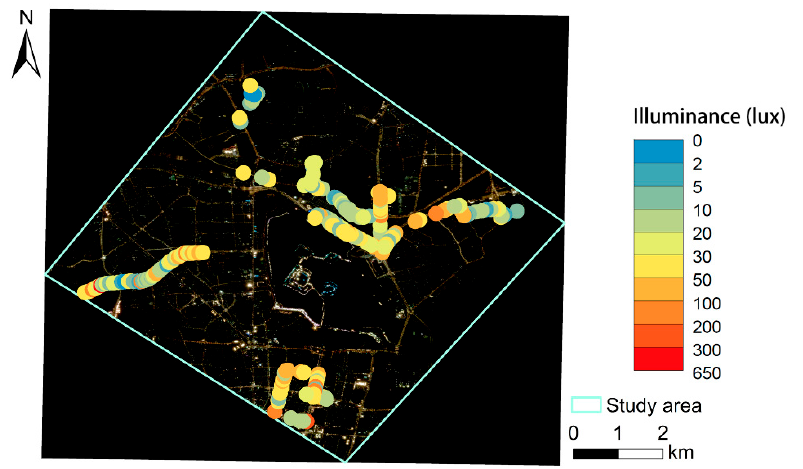
Figure 2. Distribution of measured points (base map: raw JL1-3B image).